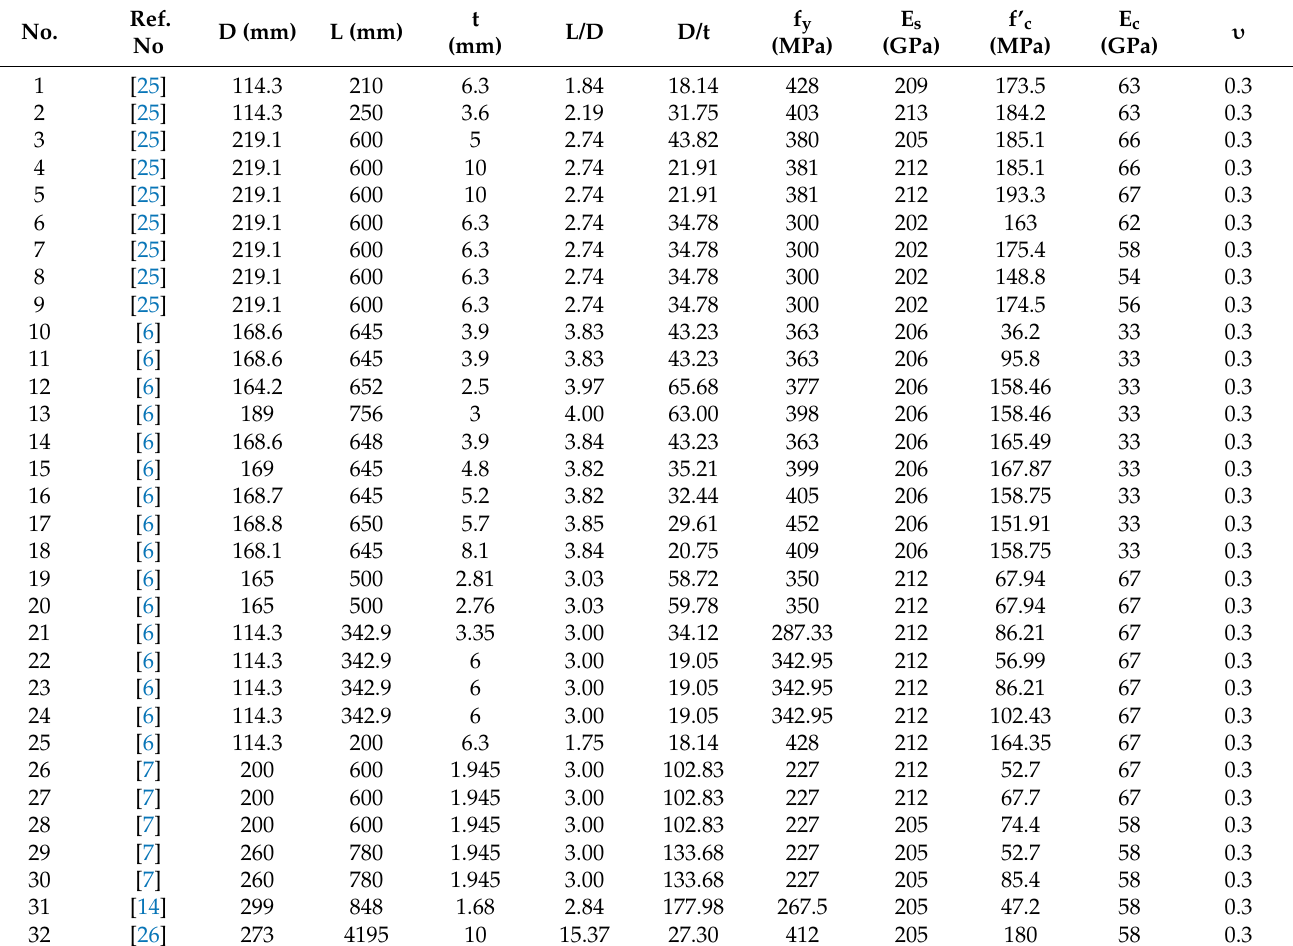
Table A1. Specification of the samples for the